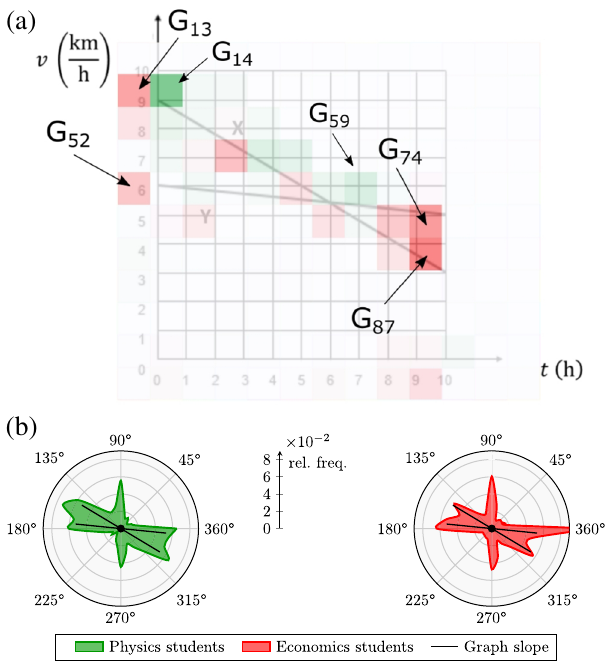
FIG. 11. Analysis of visual attention and saccadic eye move- ments for the quantitative question on area under a graph in the context of physics. Students had to calculate the distance traveled by a car during the first 8 s from the graph. For more details, please refer to the caption of Fig.